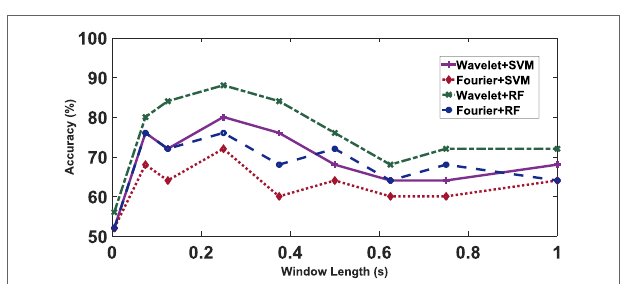
FIGURE 8 | The figure shows how accuracy of different methods changes with increasing window length . “Wavelet + *” represents we use wavelet analysis to extract feature; “Fourier + *” represents using Fourier analysis to extract feature; and SVM and RF represent the classification method Support Vector Machine and Random Forest,